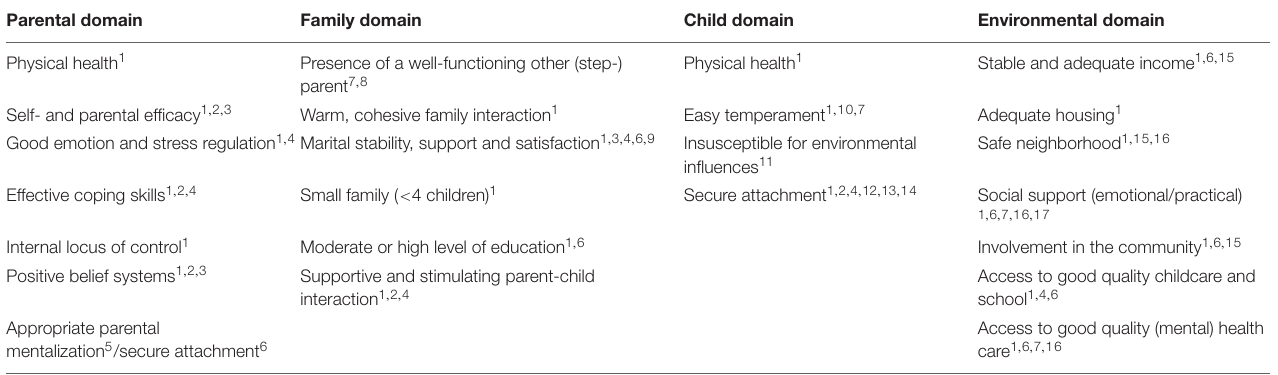
TABLE 2 | General protective factors in early childhood in different domains, which may have a buffering effect on families where a parent has a mental